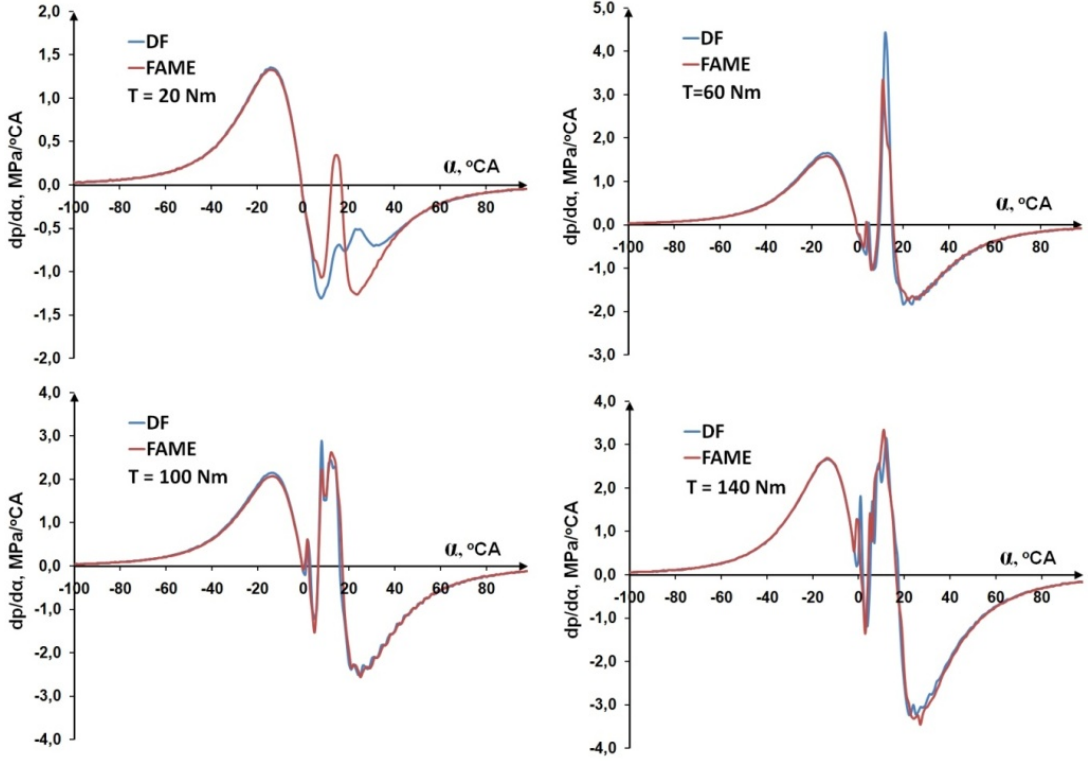
Figure 4: Waveforms of pressure increase rate dp / dα during the combustion process in the Fiat 1.3 MultiJet engine cylinder supplied with the following fuels: FAME, DF, operating according to the load characteristics for n = 1750 rpm, with loads T = 20, 60, 100 and 140 Nm